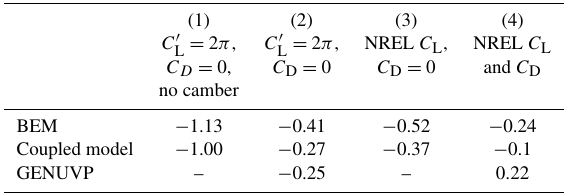
Table 2. Estimated logarithmic decrements [%] corresponding to the aerodynamic work of first in-plane vibrations at 8ms − 1 , based on the results at an amplitude of